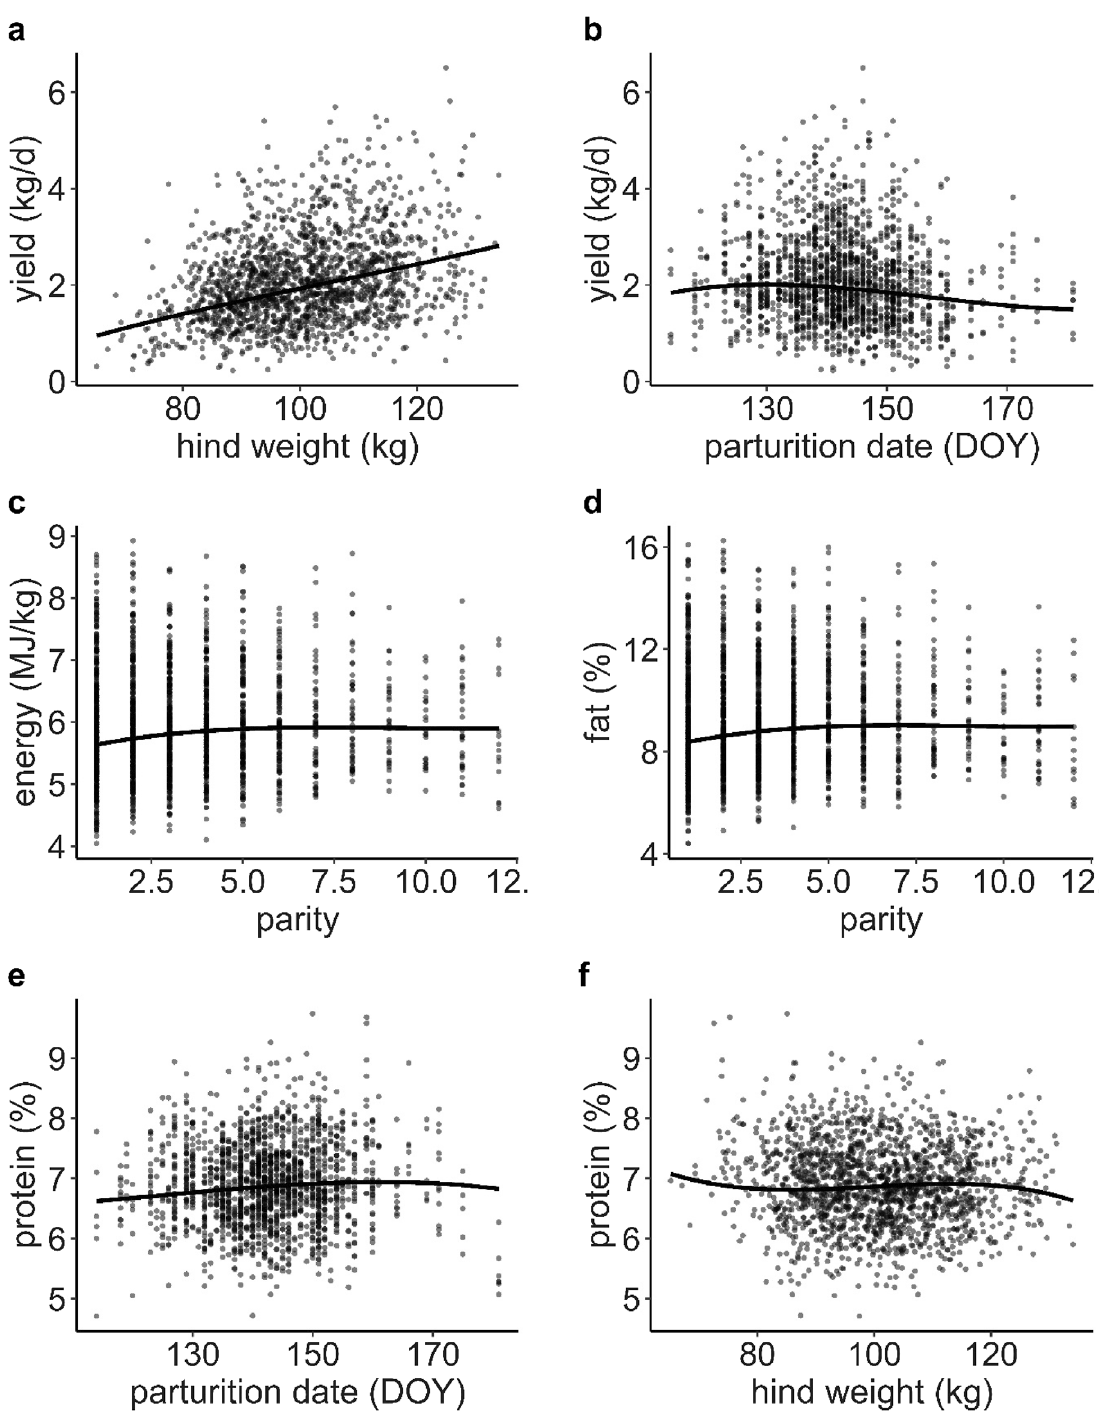
Figure 2. Predictions of the response of milk constituents against red deer hind traits using models in Supplementary Information 3 Tables